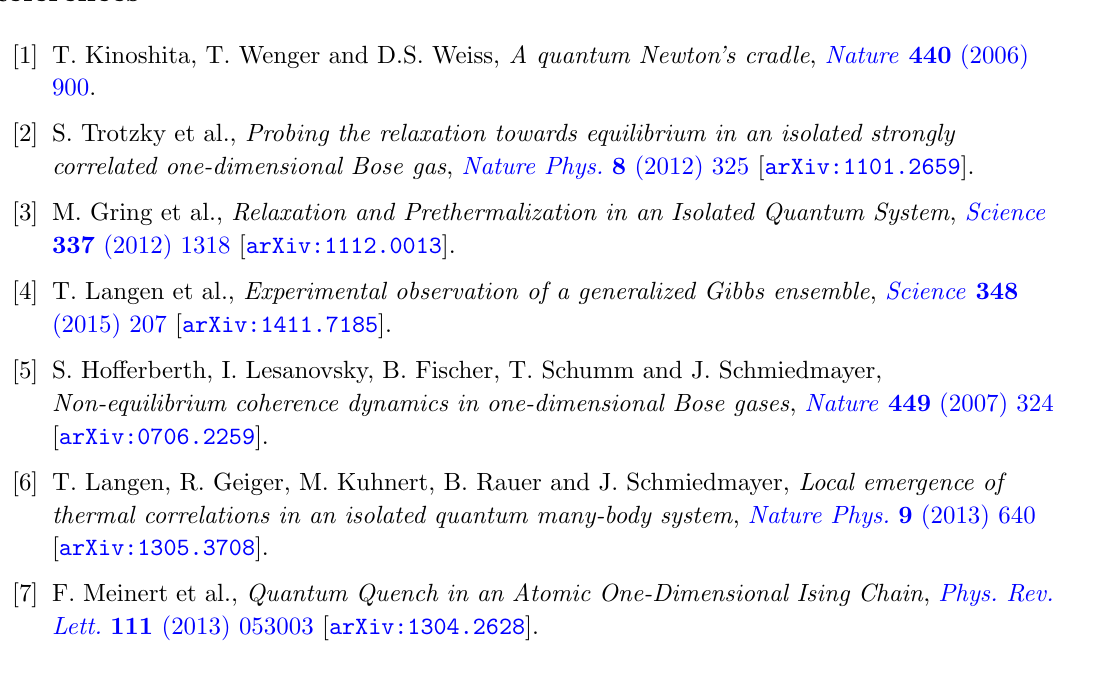
Table 5. The e(cid:11)ective central charges for (left and right) thermal states and the dynamical central charges for the partitioning protocol for various left and right temperatures in the W 3 massless (cid:13)ow, where c UV = 1 : 2 and c IR = 0 : 8. Open